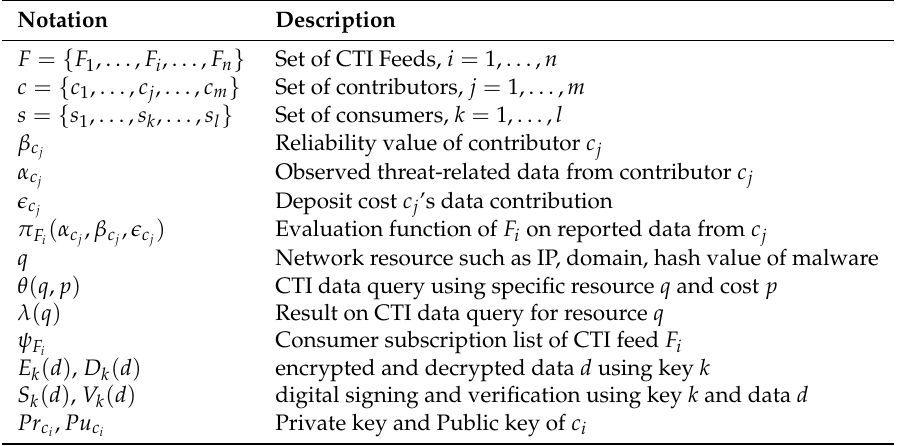
Table 1. Descriptions for notations used in the proposed framework.